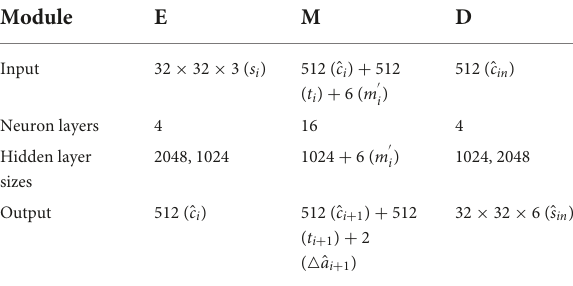
TABLE 1 pEM*D network architecture